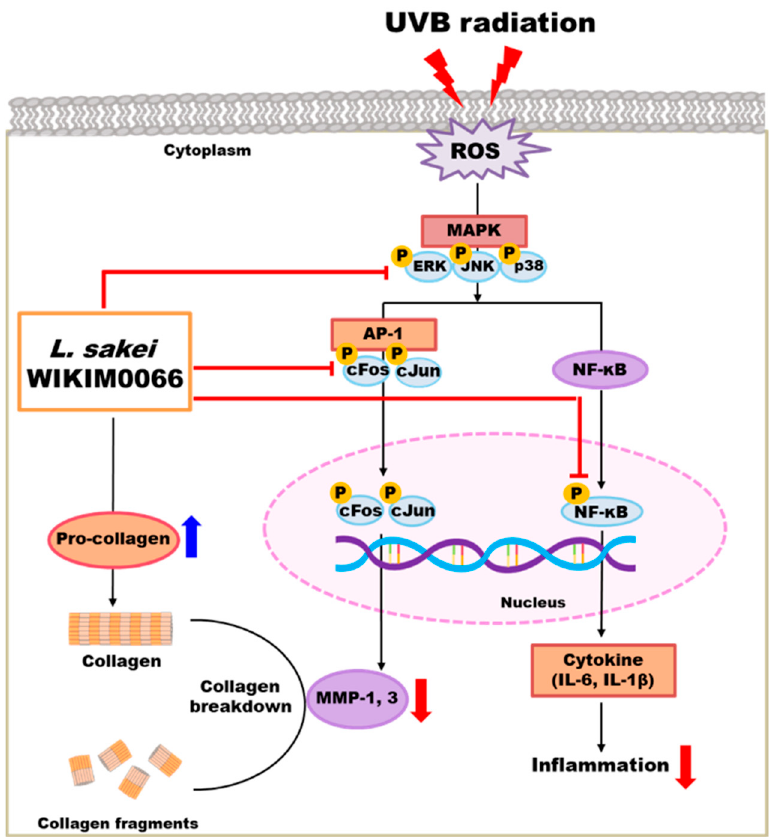
Figure 9. Schematic diagram of the effects of wikim0066 on UVB-irradiated skin cells and animal model.